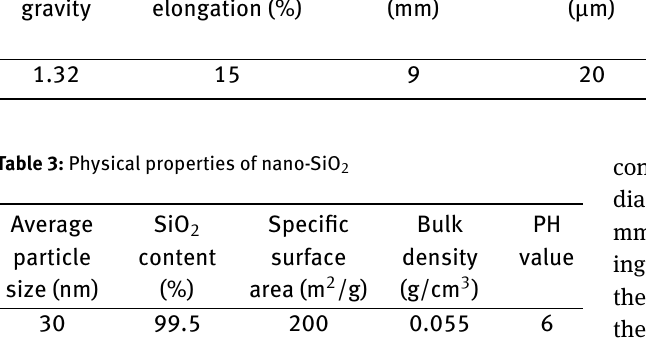
Table 2: Physical properties of PVA fiber Specific gravity